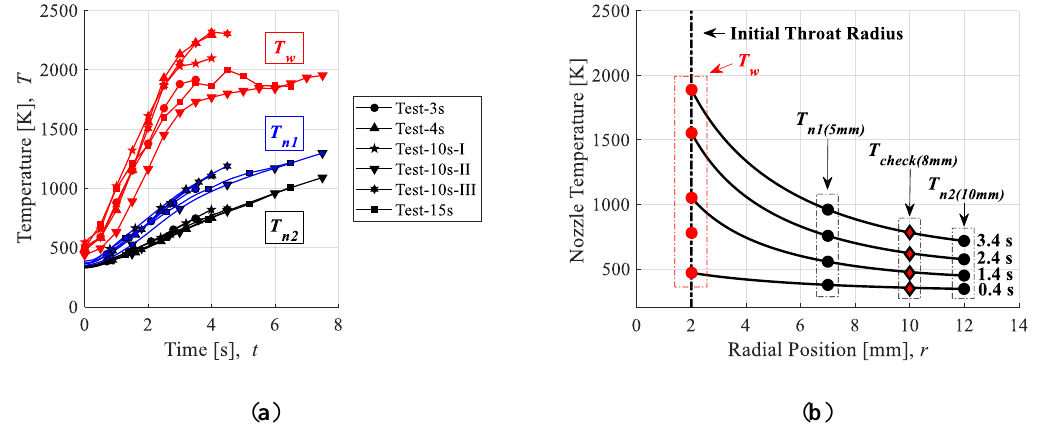
Figure 11. The TTRT analysis ( a ) nozzle temperature histories; ( b ) confirmation of temperature profile histories in Test-3s.